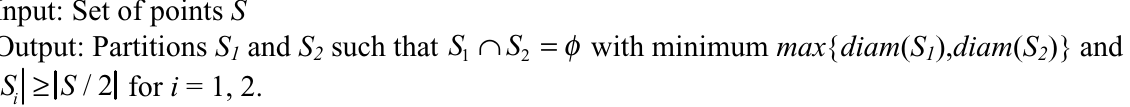
Figure 4. An example showing that an optimal balanced clustering is not necessarily a linearly separable partition. The point set contains four points, which are the endpoints of two unit-length segments ab and cd , with a being slightly to the left of cd . The optimal clustering is { a,b,c } and { d }, which is linearly separable; while the optimal balanced clustering is { a,b } and { c,d }, which is not linearly separable. Algorithm 1. Balanced minimum diameter 2-clustering